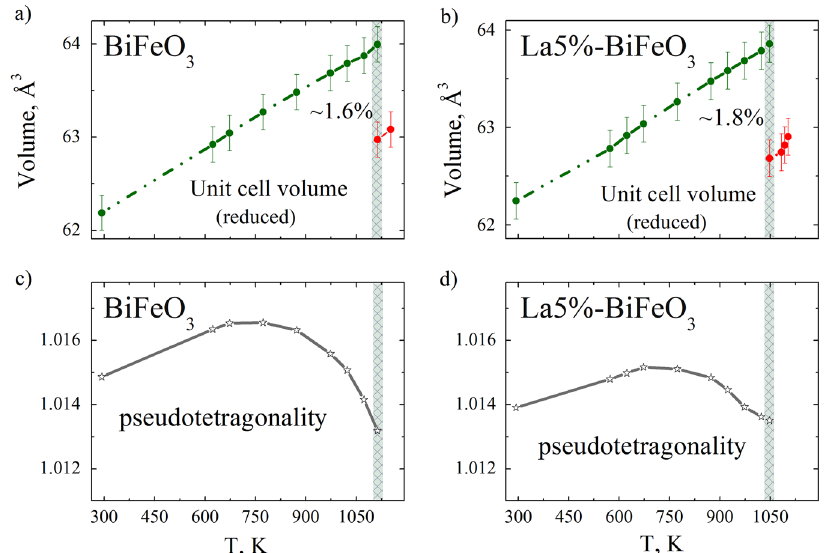
Fig. 2 Temperature evolution of the unit cell volume and tetragonality parameter calculated for the pristine a , c and La-doped b , d BiFeO 3 compounds based on the NPD data. Gray vertical stripe denotes the rhombohedral-orthorhombic